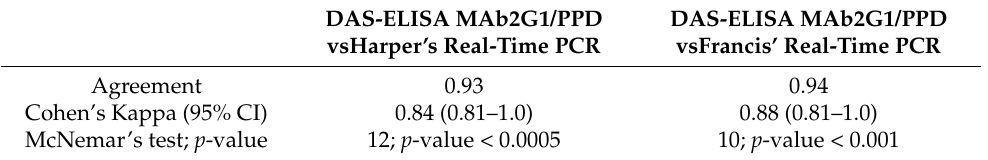
Table 6. Agreement between DAS-ELISA MAb2G1/PPD and real-time PCR by Harper et al. [31] or Francis et al. [32] for detection of X. fastidiosa in 233 tree samples from Demarcated Area for X. fastidiosa in Alicante